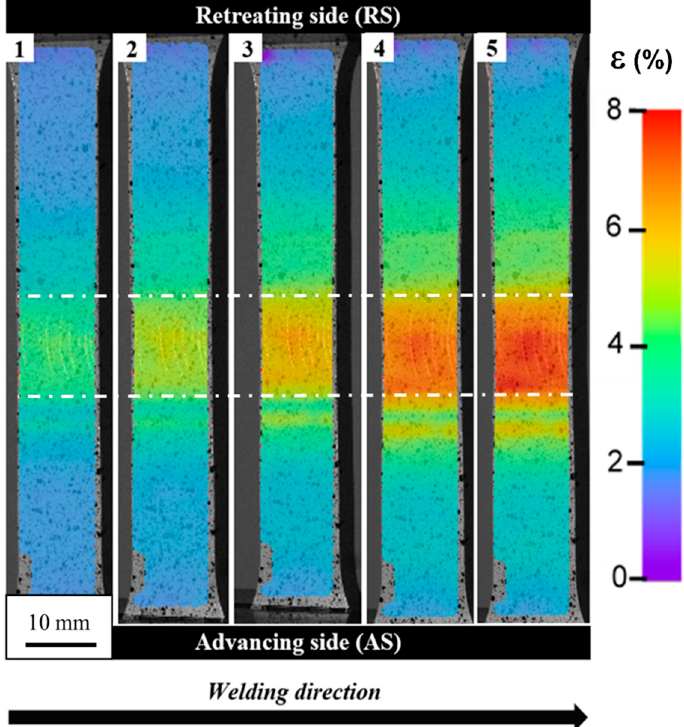
Figure 8. Strain distribution maps of the tensile sample corresponding to the points marked in Figure 7. Weld faces marked with white lines.